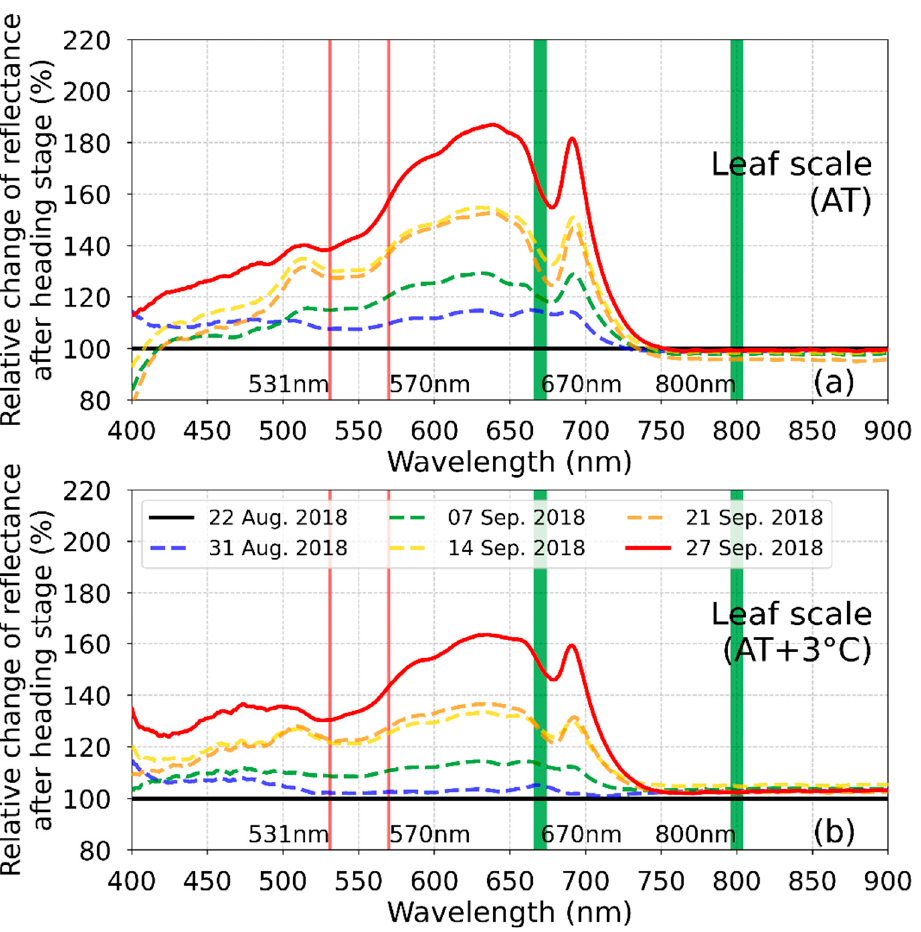
Figure 7. Relative change of spectral reflectance measured from leaf ‐ spectrometer (leaf scale) after the heading stage of paddy rice at ( a ) AT and ( b ) AT+3 °C positions. The vertical red lines denote 531 nm and 570 nm and are used to compute PRI, and the vertical green lines denote 670 nm and 800 nm and are used to calculate NDVI. The black solid line is the standard, which is based on spectral reflectance measured on August 22, 2018. The blue, green, gold, and orange dashed lines were measured on 31 August 2018, 7 September 2018, 14 September 2018, and 21 September 2018, respectively. The red solid line represents the final measurement of the change ratio of spectral reflectance after the heading stage.